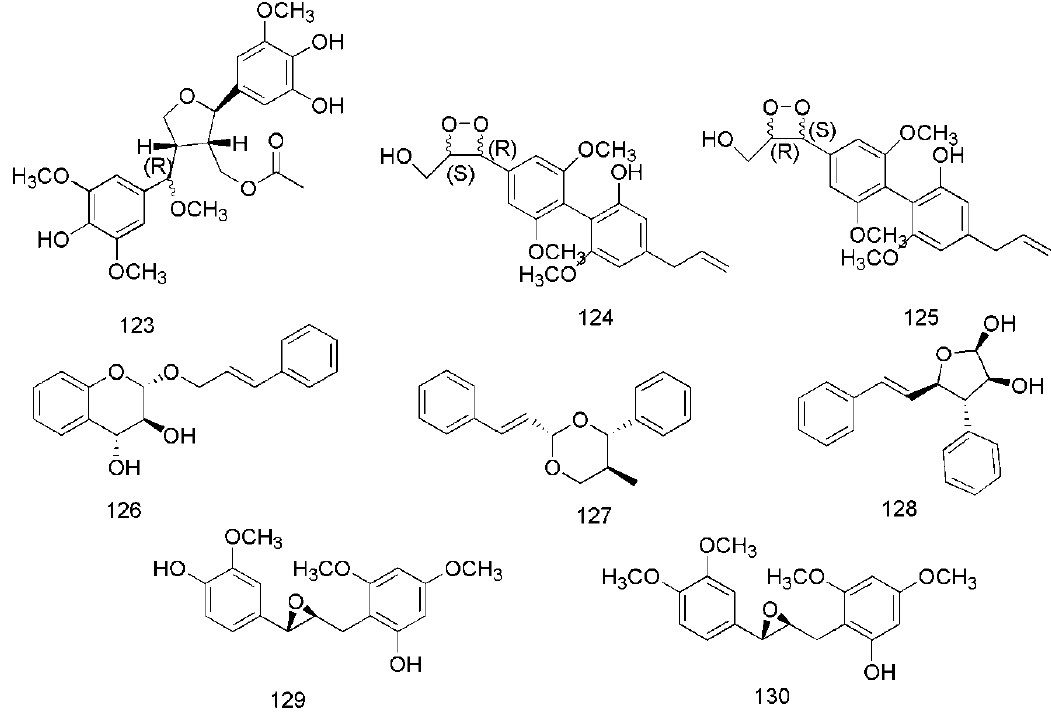
Figure 7. Chemical structures of the lignans in C. cassia .